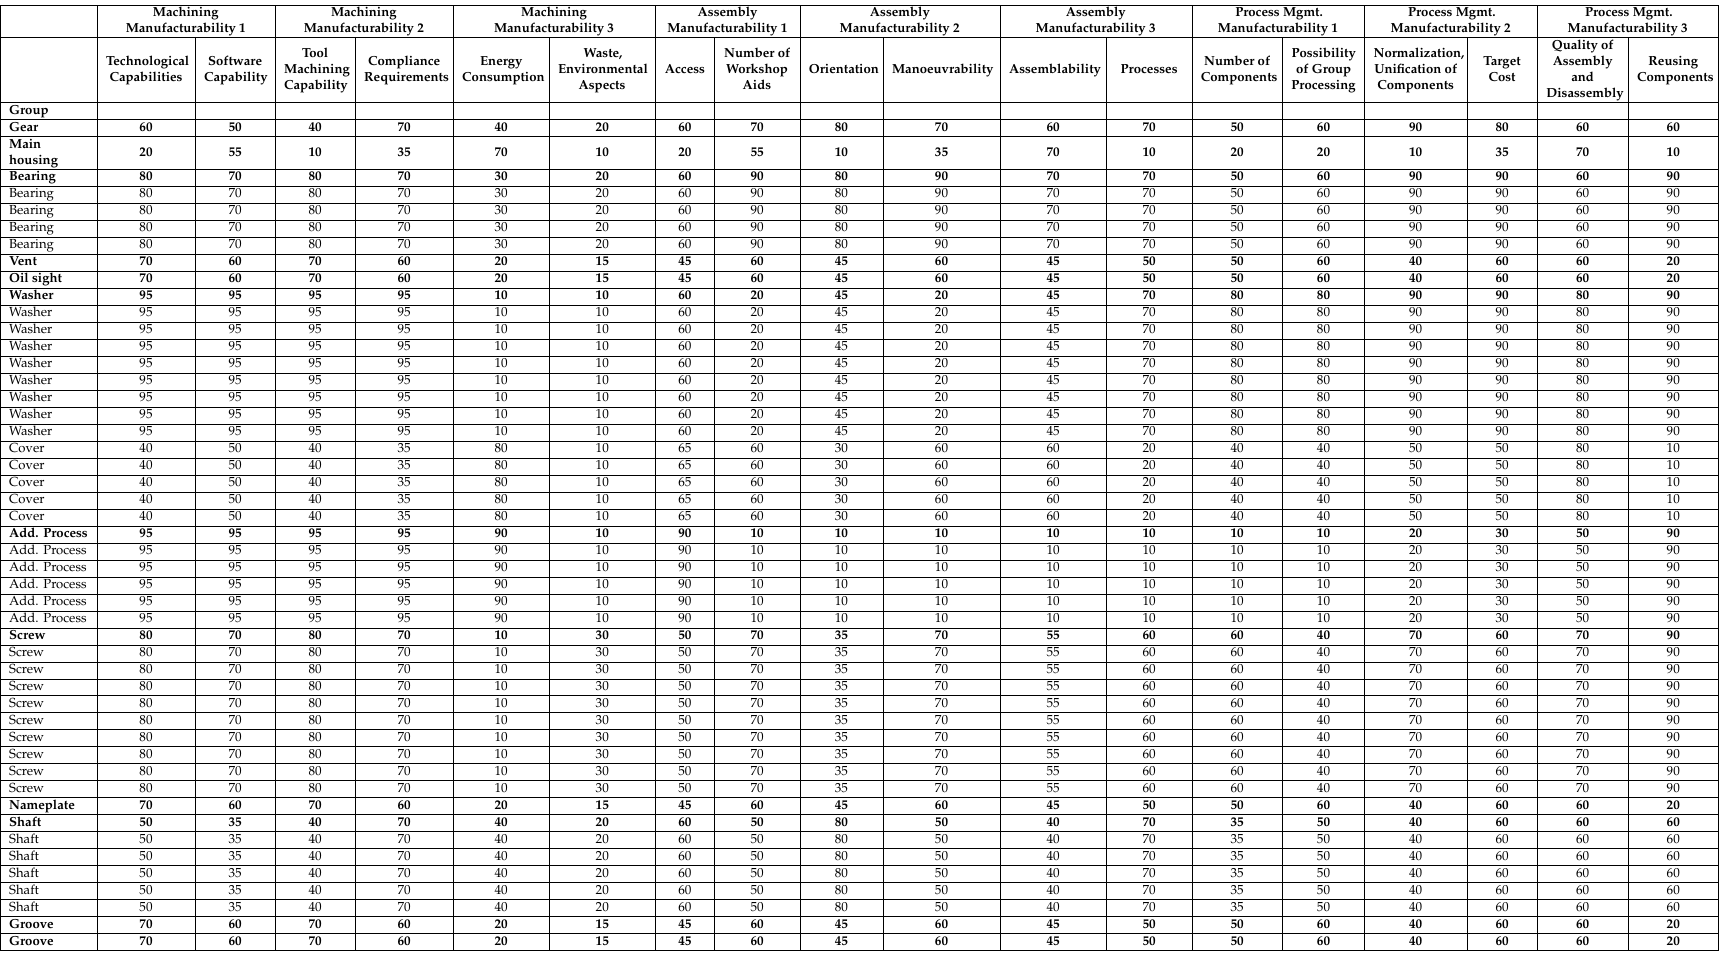
Table 13. Set of component assessments made by experts for established criteria.